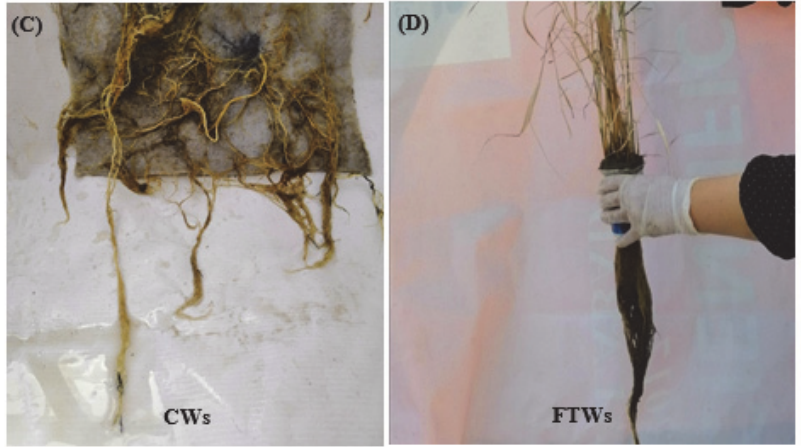
Figure 8. Phragmites australis growth comparison in CWs and FTWs: ( A ) P. australis growth in CWs; ( B ) P. australis growth in FTWs; ( C ) P. australis root growth in CWs; ( D ) P. australis root growth in FTWs.